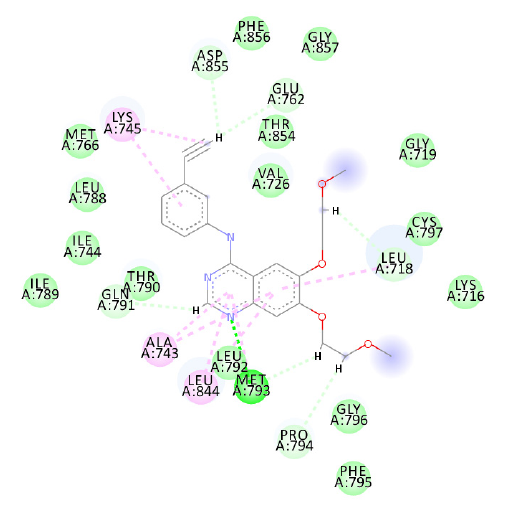
Figure 7. The position of erlotinib in ATP binding site of EGFR ( left ) and two-dimensional interaction of erlotinib to wildtype EGFR ( right ): , hydrogen bond; , van der Waals; , metal acceptor; , pi-alkyl.